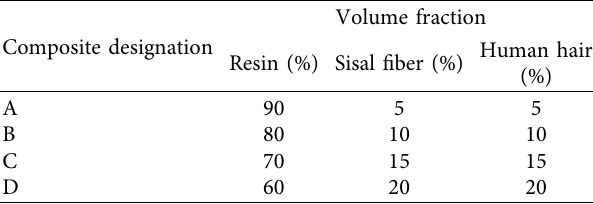
Table 1: Composition and designation of